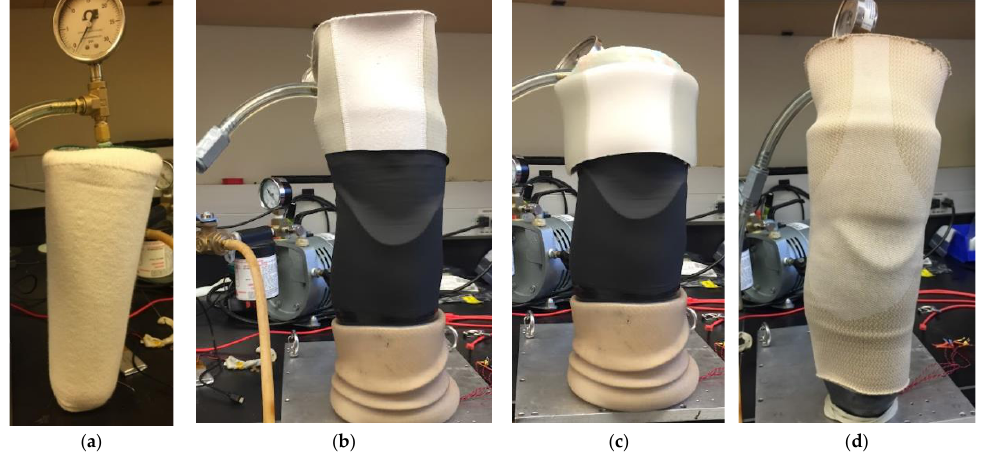
Figure 4. Calibration set up. ( a ) A sock is placed over the balloon to prevent it from sticking to the inner surface of the liner. The balloon is inflated to a pressure of 3.4 kPa. ( b ) The balloon is placed within the liner, and a gaiter sleeve (black) is pulled into position over the upper part of the socket and the bottom part of the liner. ( c ) The proximal end of the liner is folded over at the top. ( d ) The sealing sleeve (tan) is rolled up onto the proximal socket and balloon to create a seal at both the distal and proximal ends of the socket.